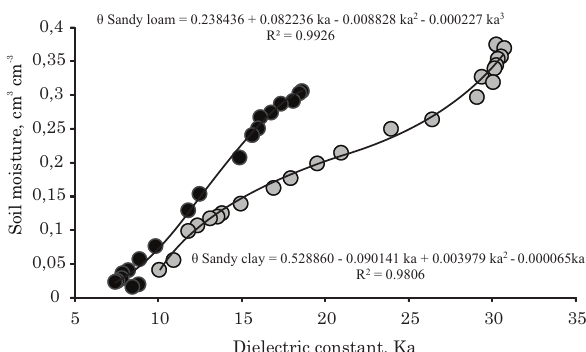
Figure 2. Array of probes in the profile of the plot, divided in four sectors of water monitoring, using 4 probes (P1); 8 probes (P2), 12 probes (P3) and 16 probes